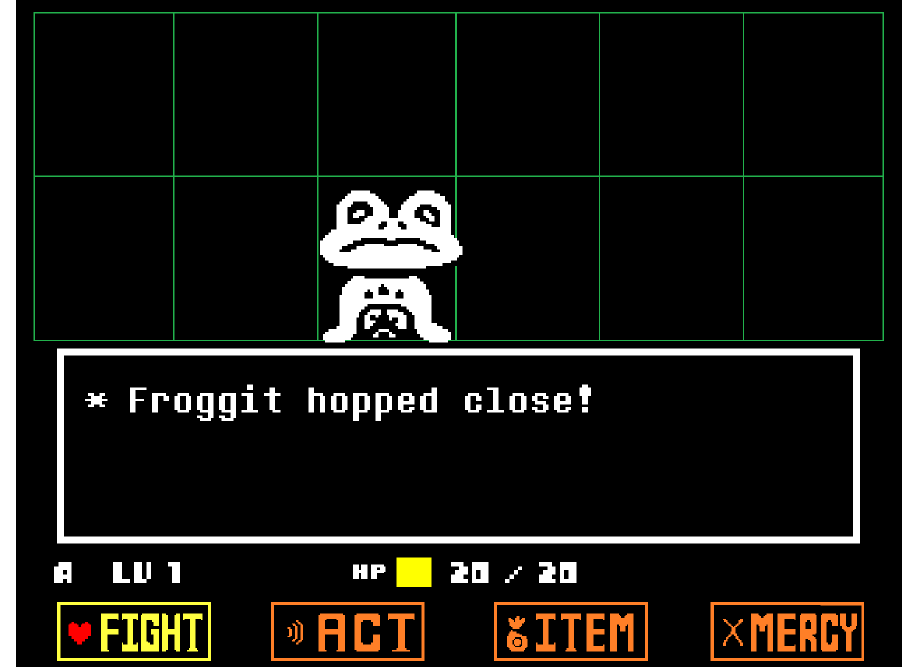
Figure 1. A screenshot from Undertale showing the first random encounter of the game, in which a “Froggit” “hops close” (note that aggression is implied via the convention of a random encounter but not by the text). The options are “fight,” “act,” “item,” and “mercy,” the last of which is unconventional. Screenshot by Peter Mawhorter, licensed under Creative Commons Attribution-ShareAlike 4.0 International License (CC BY